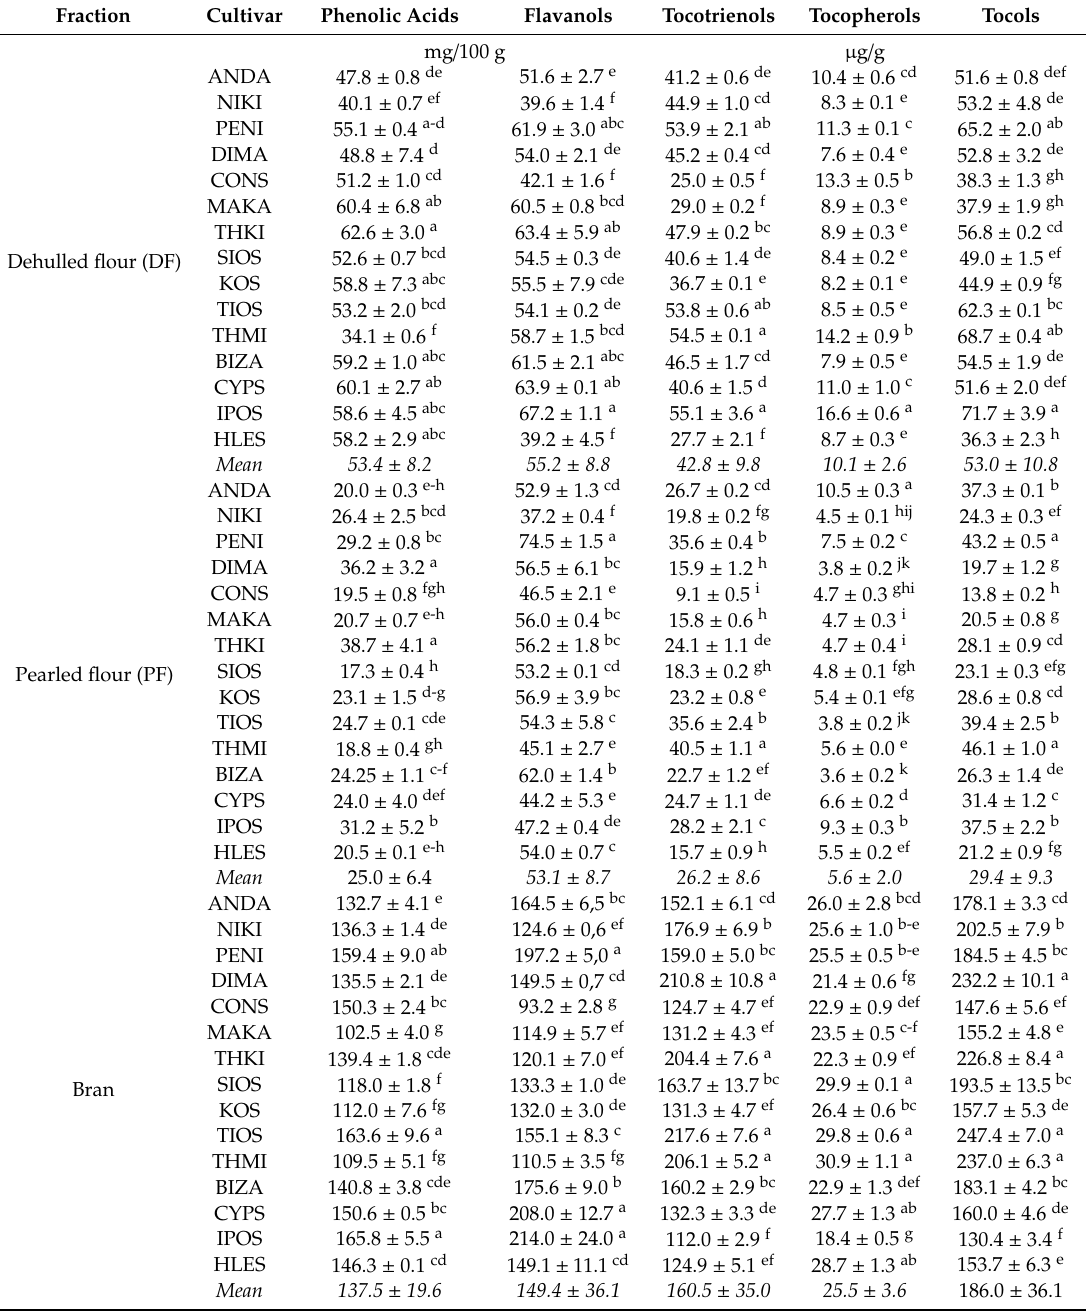
Table 4. Phenolic acids, flavanols, tocotrienols, tocopherols and tocols contents of three fractions among barley cultivars tested as determined by HPLC